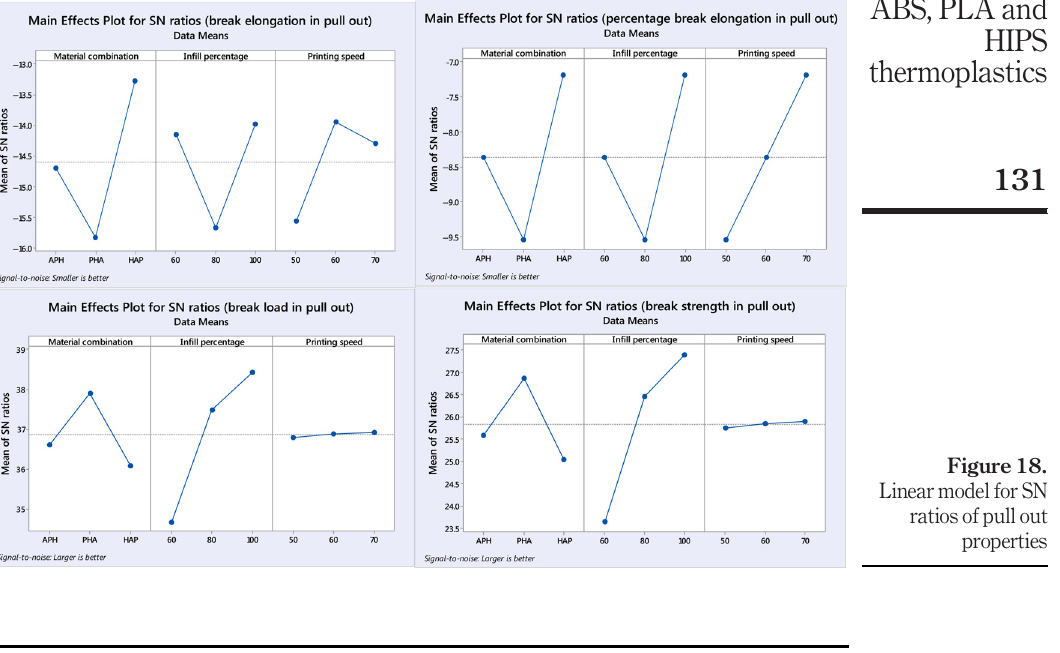
Table III. Analysis of variance